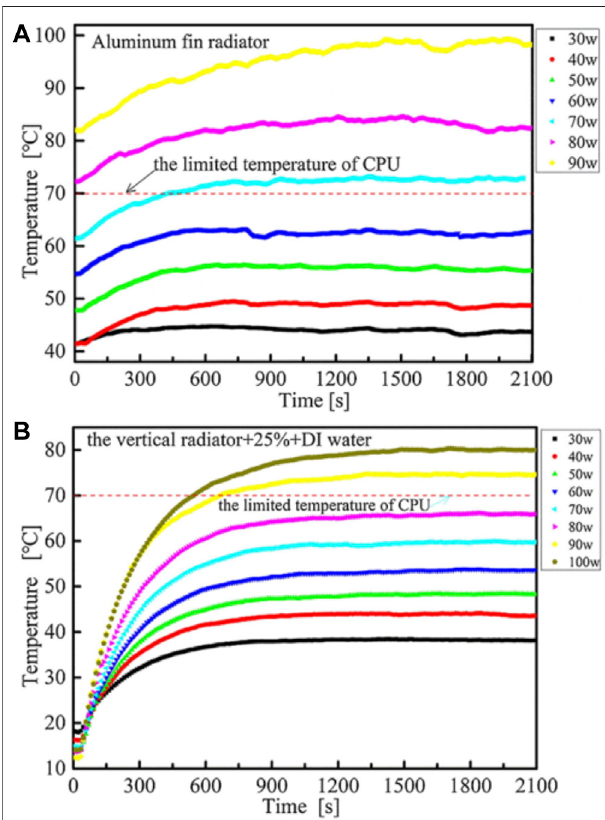
FIGURE 9 | Temperature change of (A) the aluminum fi n radiator, and (B) the novel vertical pulsating heat pipe radiator under different input power (Xiahou et al.,